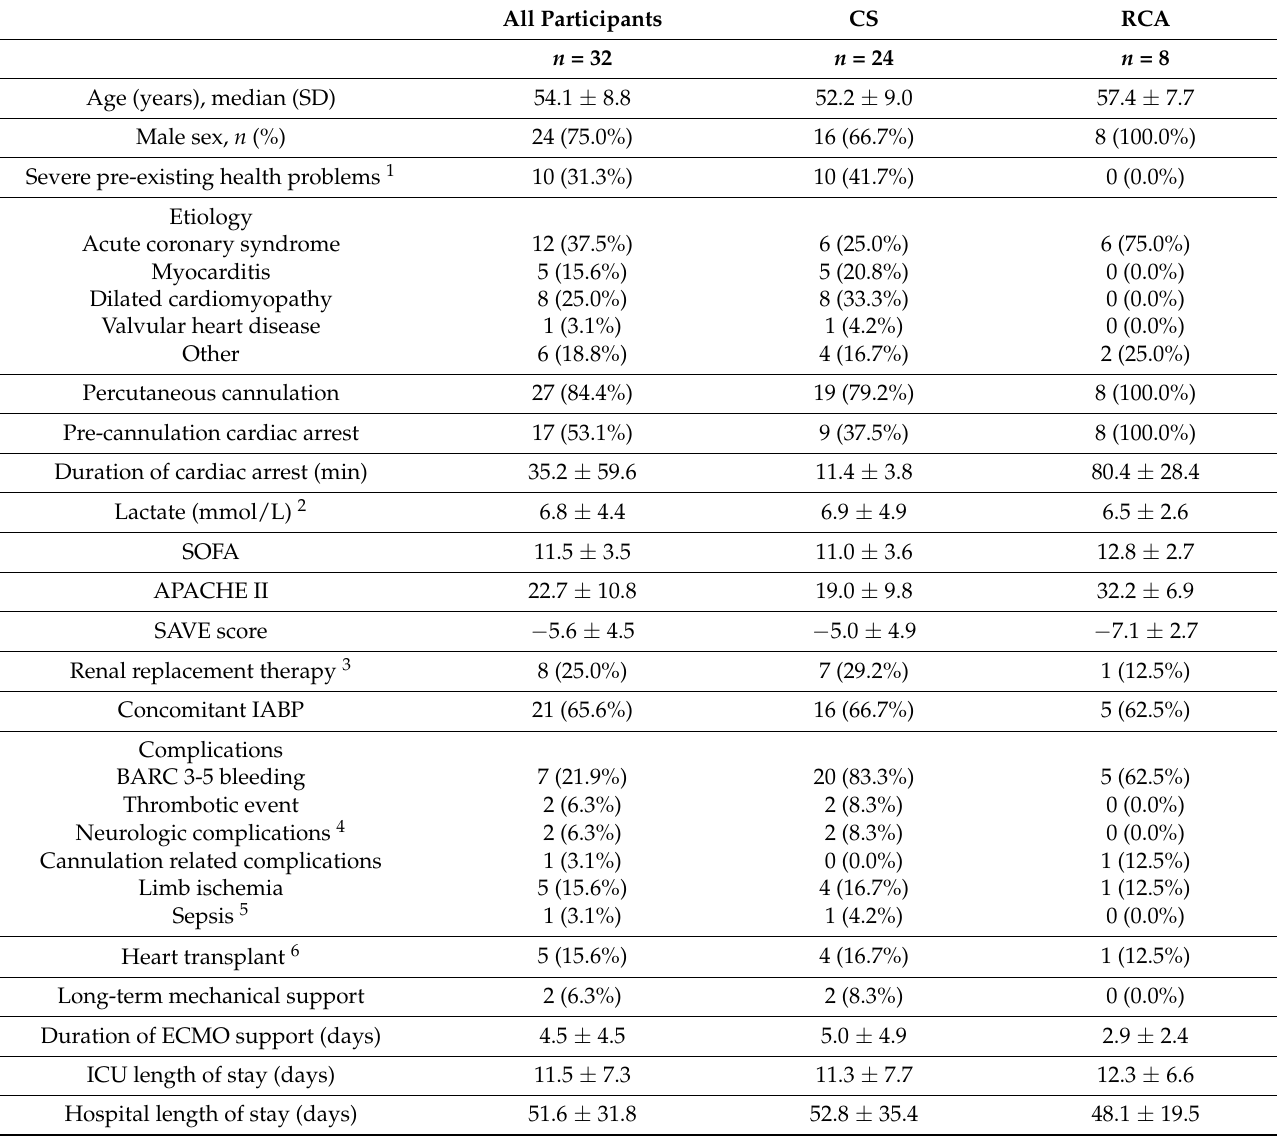
Table 1. Characteristics of patients who participated in